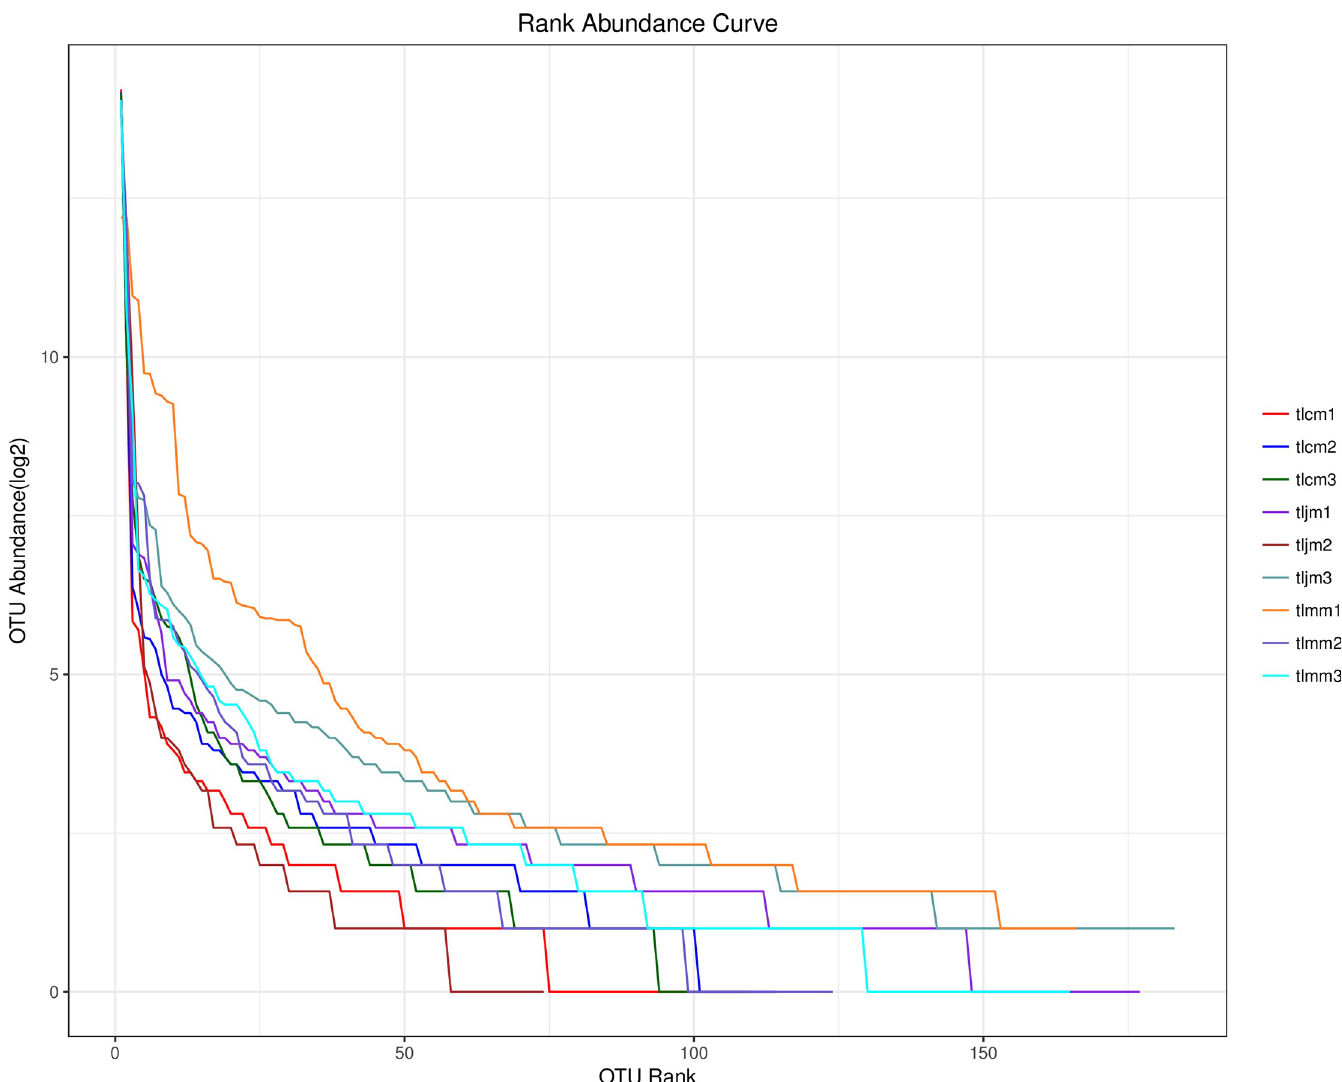
Fig 3. Rank abundance curve of each sample. Note: The abscissa represents the ordinal of the OTU, and the ordinate represents the abundance of the OTU. The larger the curve span, the richer the composition of the species was. The flatter the curve, the higher the evenness the species composition was. tlcm 1–3 represented the healthy control group samples 1–3, tlmm1-3 represented the diarrhea model group samples 1–3, tljm 1–3 represented the D . hansenii treatment samples 1–3.